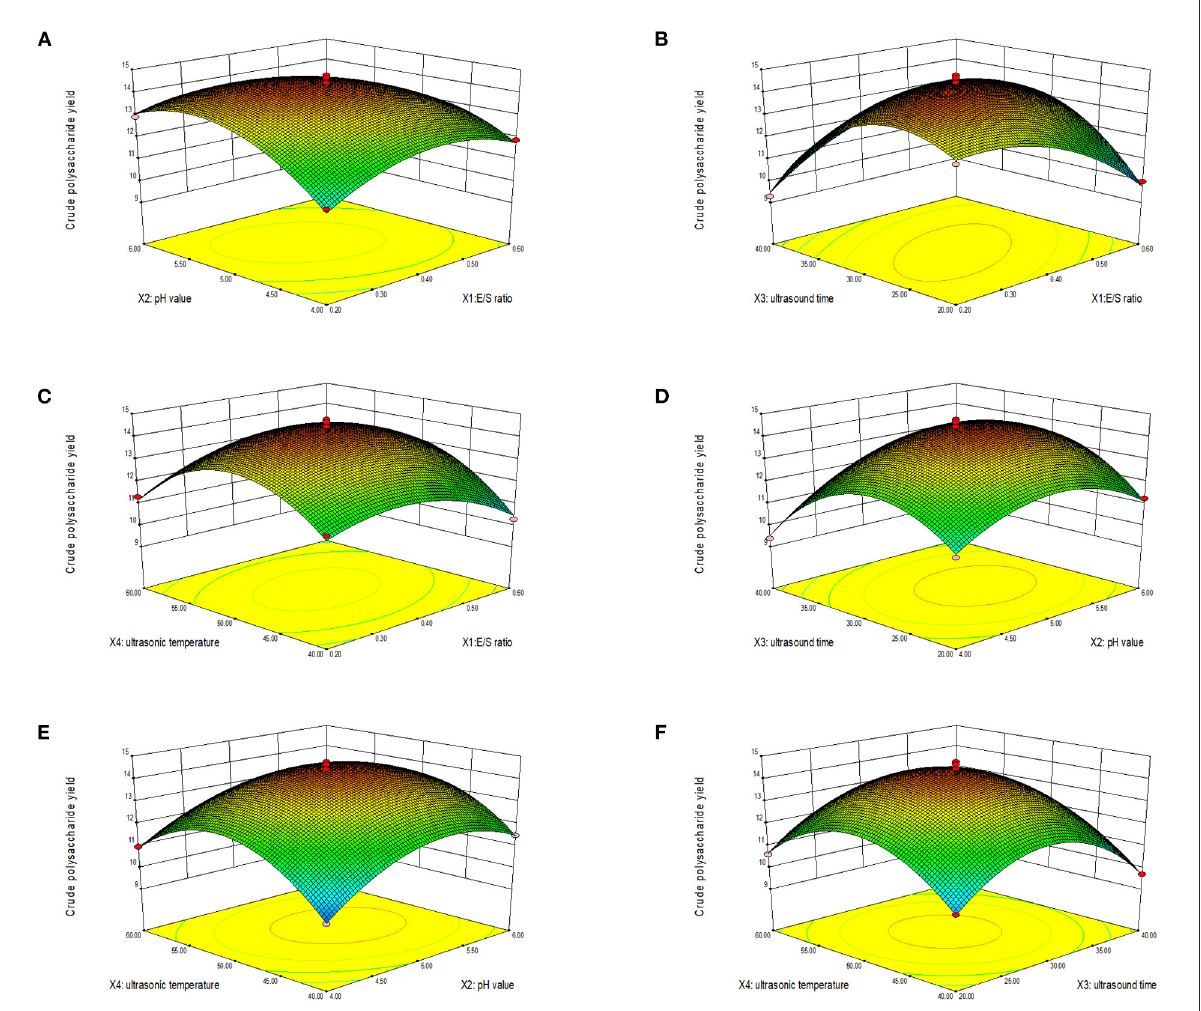
FIGURE2 Response surface (3D) showing the effect of E/S ratio and pH value (A) , E/S ratio and ultrasonic time (B) , E/S ratio and ultrasonic temperature (C) , pH value and ultrasonic time (D) , pH value and ultrasonic temperature (E) , and ultrasonic time and ultrasonic temperature (F) on extraction yield of